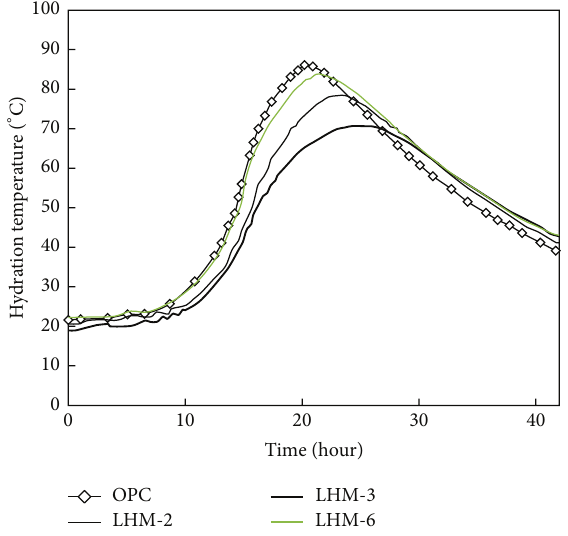
Figure 3: Semiadiabatic temperature rise test.